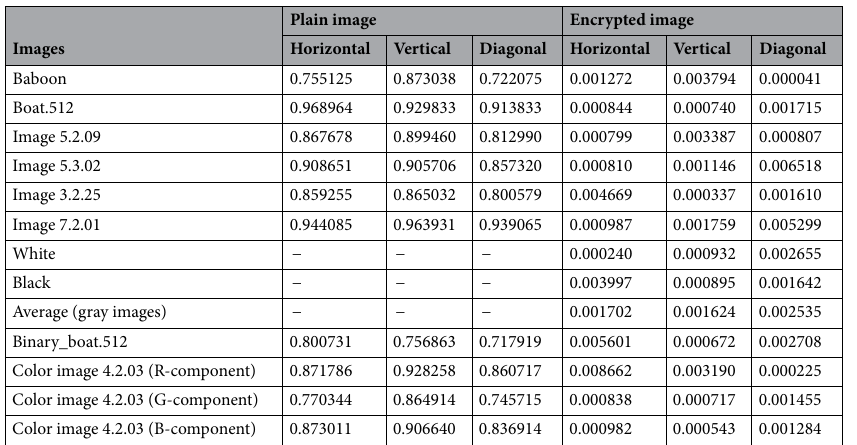
Table 3. Correlation coefficient of images.